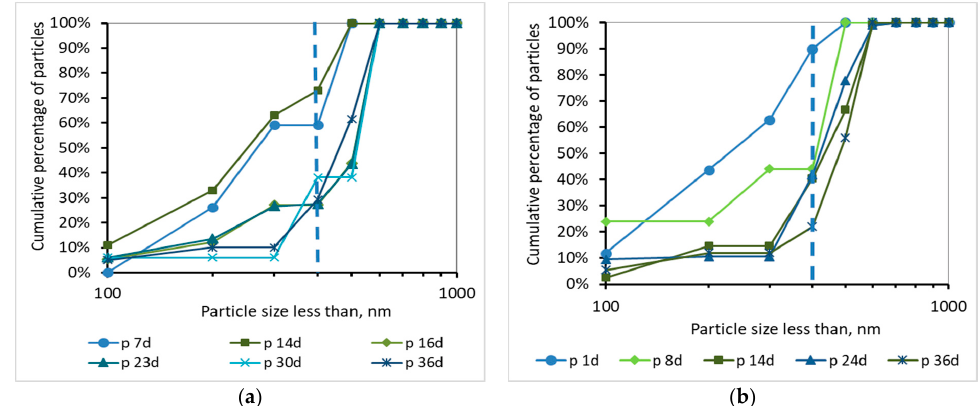
Figure 11. Cumulative percentage of particles smaller than 1000 nm for samples of the permeate (p) as a function of MBR operation time ( a ) for synthetic versus ( b ) domestic wastewater.